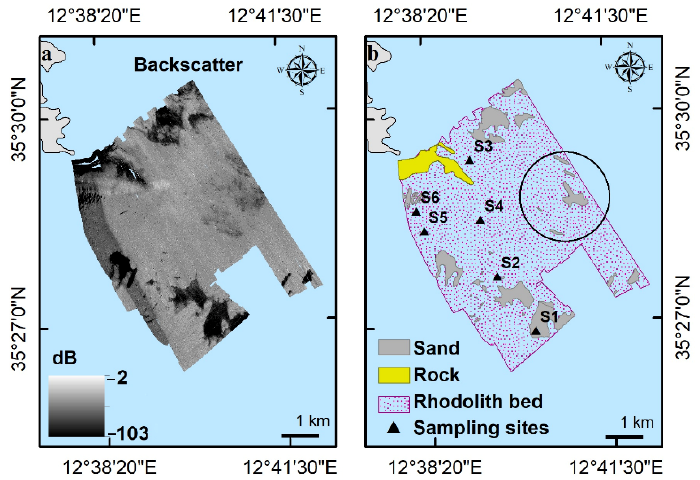
Figure 3. ( a ) Distribution of the backscatter intensity (sonogram) produced by the multibeam sys- tem; ( b ) simplified classification of sediments in the study area. The circle indicates an area with fewer rhodoliths; sampling sites are also reported.